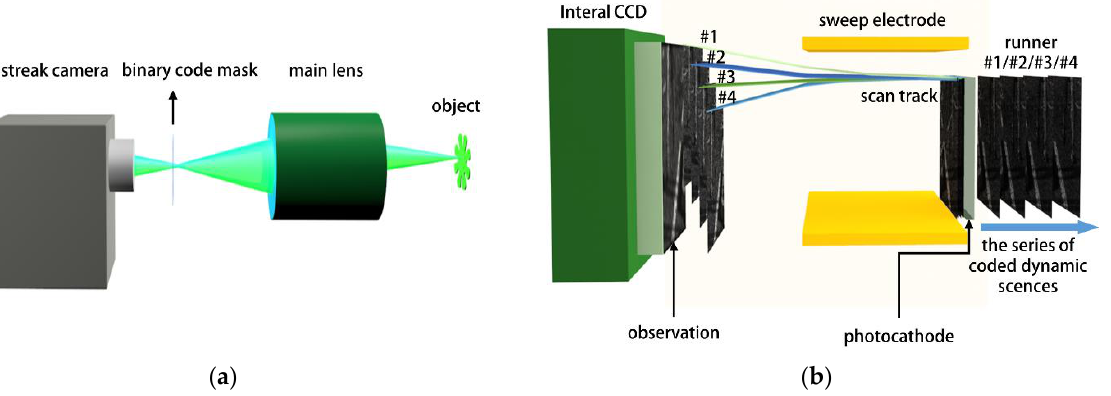
Figure 2. Schematic diagram of the CUP system. ( a ) Schematic diagram of the optical path structure of the CUP. ( b ) Schematic diagram of the time series of the encoded dynamic scene being shifted after entering the streak camera.